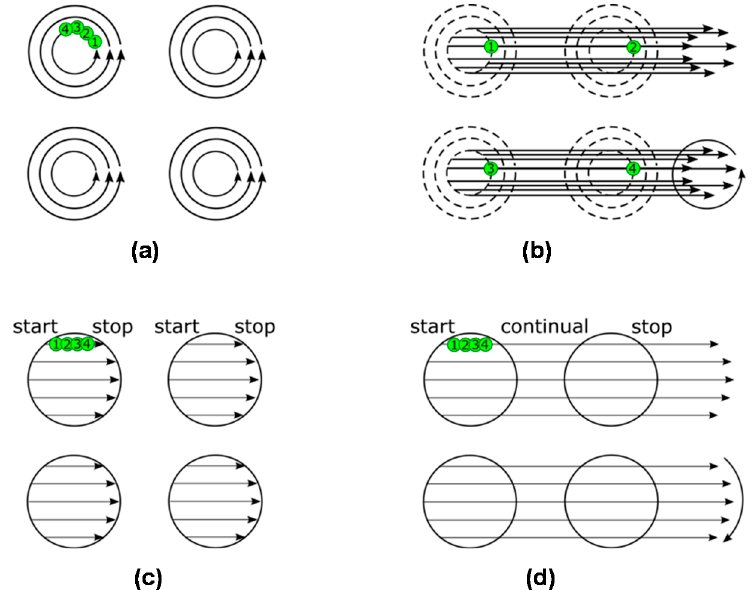
Figure 1. Schematic representation of the laser surface texturing (LST) methods: ( a ) classic path filling, ( b ) shifted path filling, ( c ) classic hatch and ( d ) shifted burst. Green dots represent laser pulses. Numbers describe the order of laser processing. Black arrows indicate the movement of the laser beam during pulsing. Curved arrows for shifted methods represent the shifting of the raster during the process.